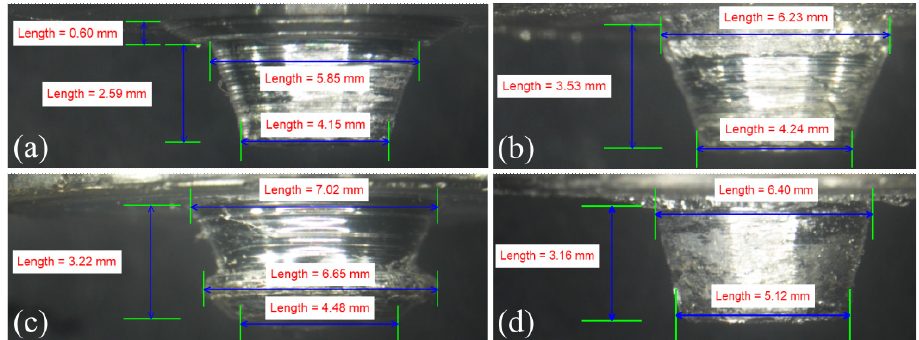
Figure 14. The variation in the tool pin geometry when welding at 1200 rpm: ( a ) the weld material adhered to tool surface; ( b ) the weld material was removed from the tool surface when the tool traverse speed was 60 mm/min; ( c ) the weld material adhered to the tool surface; and ( d ) the weld material was removed from the tool surface when the tool traverse speed was 90 mm/min.